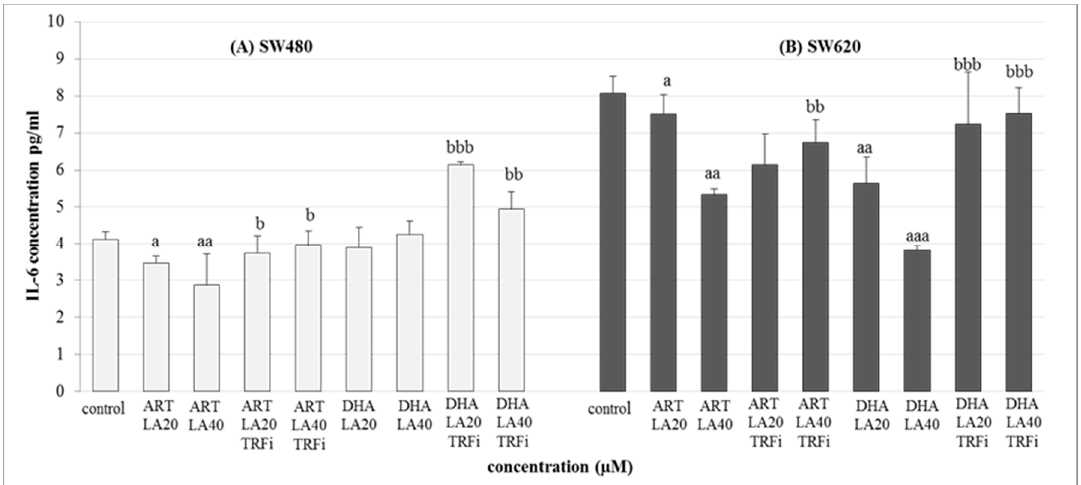
Figure 5. The effect of ART, DHA, and LA with or without TRFi on IL-6 levels in ( A ) SW480 and ( B ) SW620 cancer cells. Cells were incubated for 72 h with studied compounds at their IC 50 concentrations. IL-6 levels in culture medium were measured by ELISA test. Data are expressed as means ± S.D. from three independent experiments performed in triplicate. aaa p < 0.001, aa p < 0.01, a p < 0.05 as compared to the control and bbb p < 0.001, bb p < 0.01, b p < 0.05 as compared to the ART or DHA with LA 20 or 40.